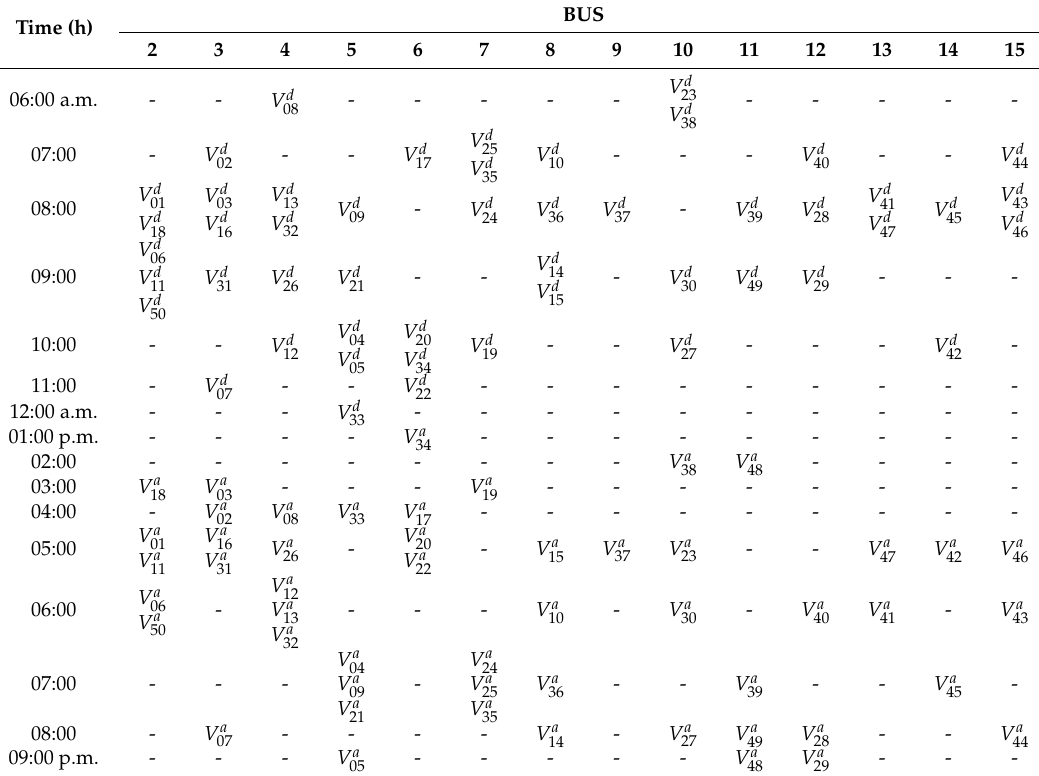
Table 3. EVs ( V x n ) departure ( d )/arrival ( a ) time